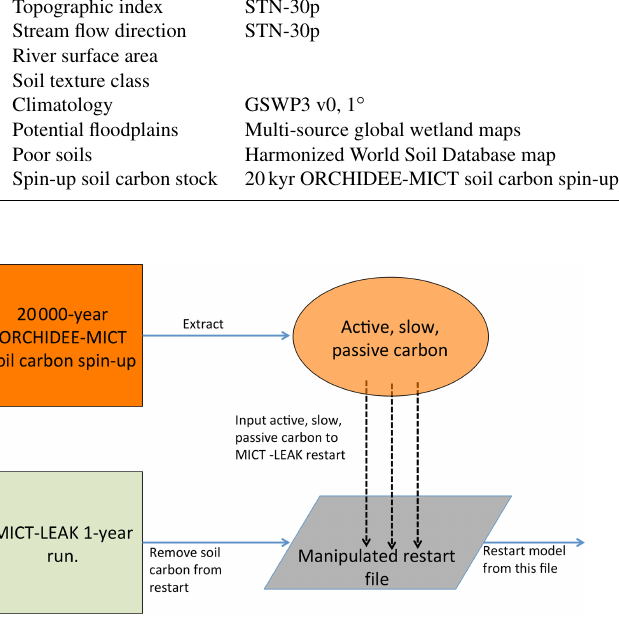
Figure 3. Flow diagram illustrating the stepwise stages required to implement the model’s soil carbon stock prior to conducting tran- sient historical